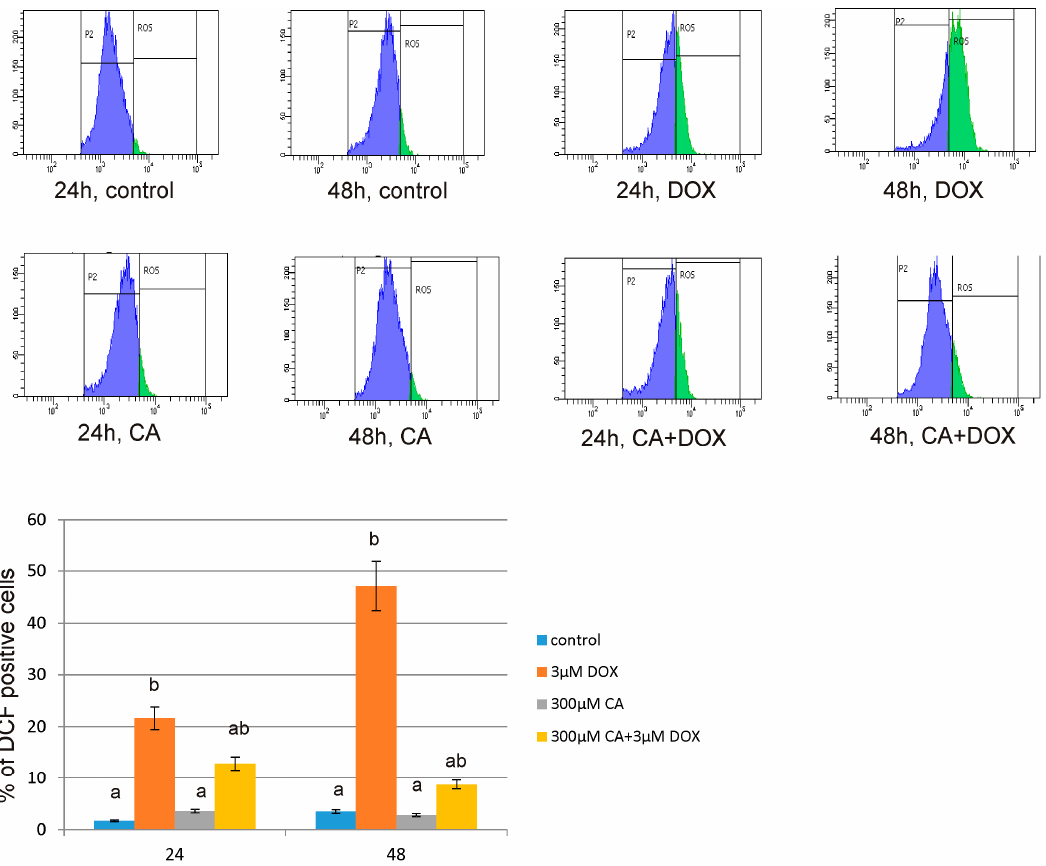
Figure 10. The effect of DOX, CA and CA + DOX on the level of intracellular ROS examined by flow cytometry in fibroblast cells. This Figure shows representative histograms of fibroblasts FACS analysis and the percentage of fibroblast cells generating intracellular ROS. The cells were incubated with 3 µ M DOX, 300 µ M CA and DOX (3 µ M) combined with CA (300 µ M) for 24 h and 48 h Mean values from three independent experiments ± SD are shown. Different letters (a, b) indicate statistical differences ( p ≤ 0.05) between control, 3 µ M DOX, 300 µ M CA and DOX combined with CA estimated by Tukey’s test